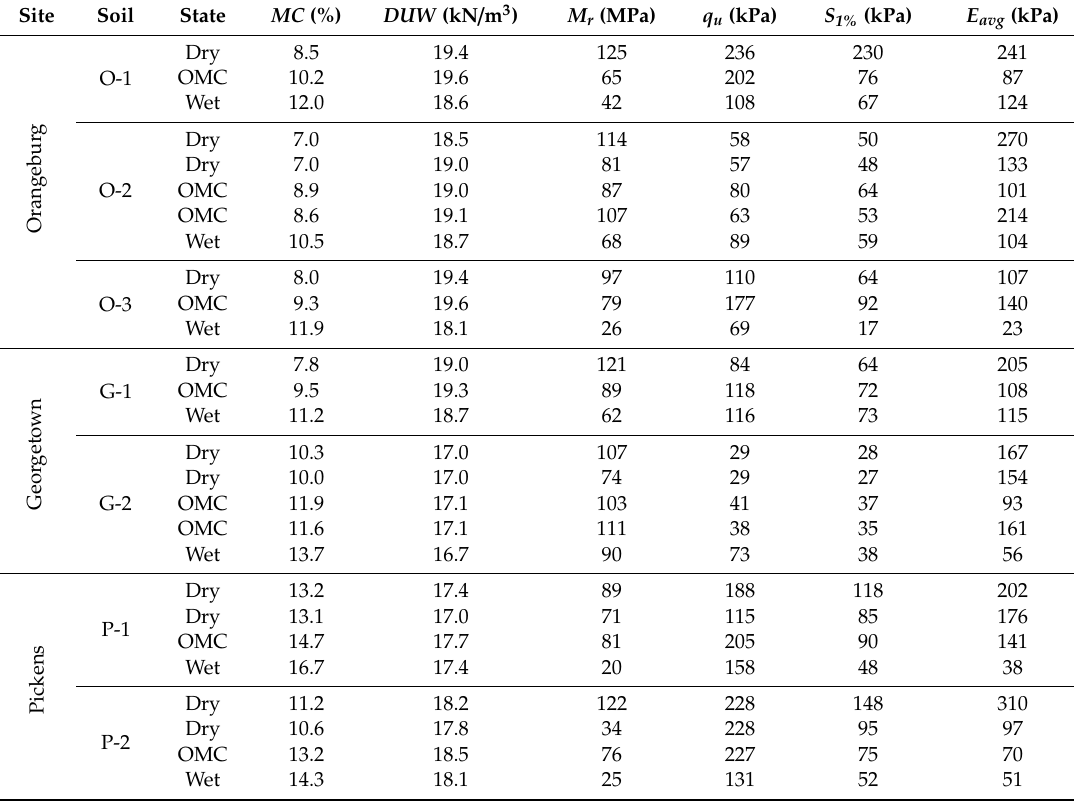
Table 2. Summary of resilient modulus and quick shear (QS) test results for remolded specimens.